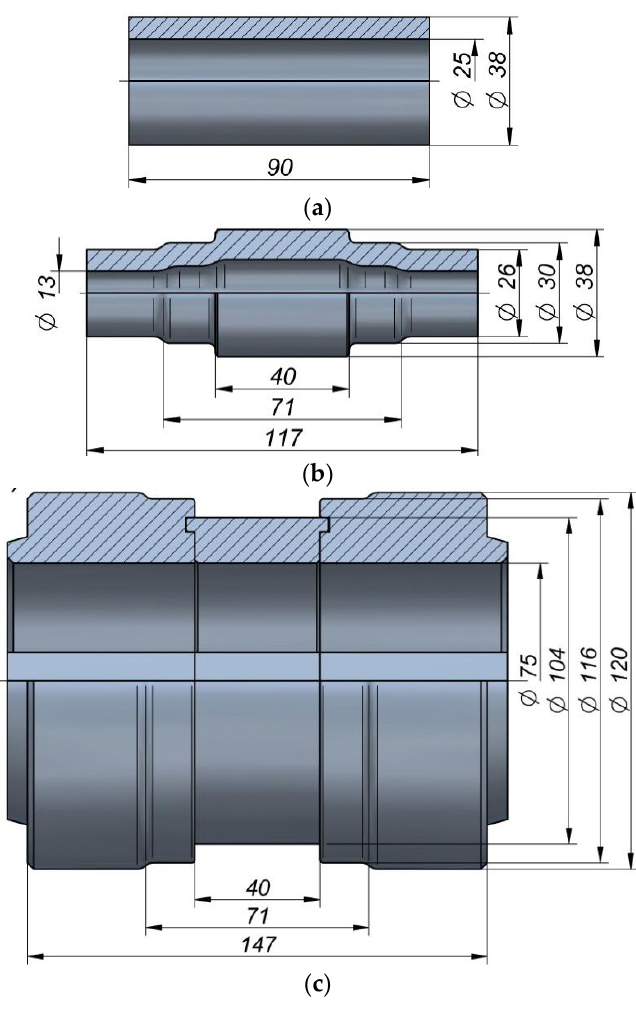
Figure 2. Shape and dimensions of: billet (tube)( a ), semi-finished product ( b ), tools ( c ), in Operation 1.